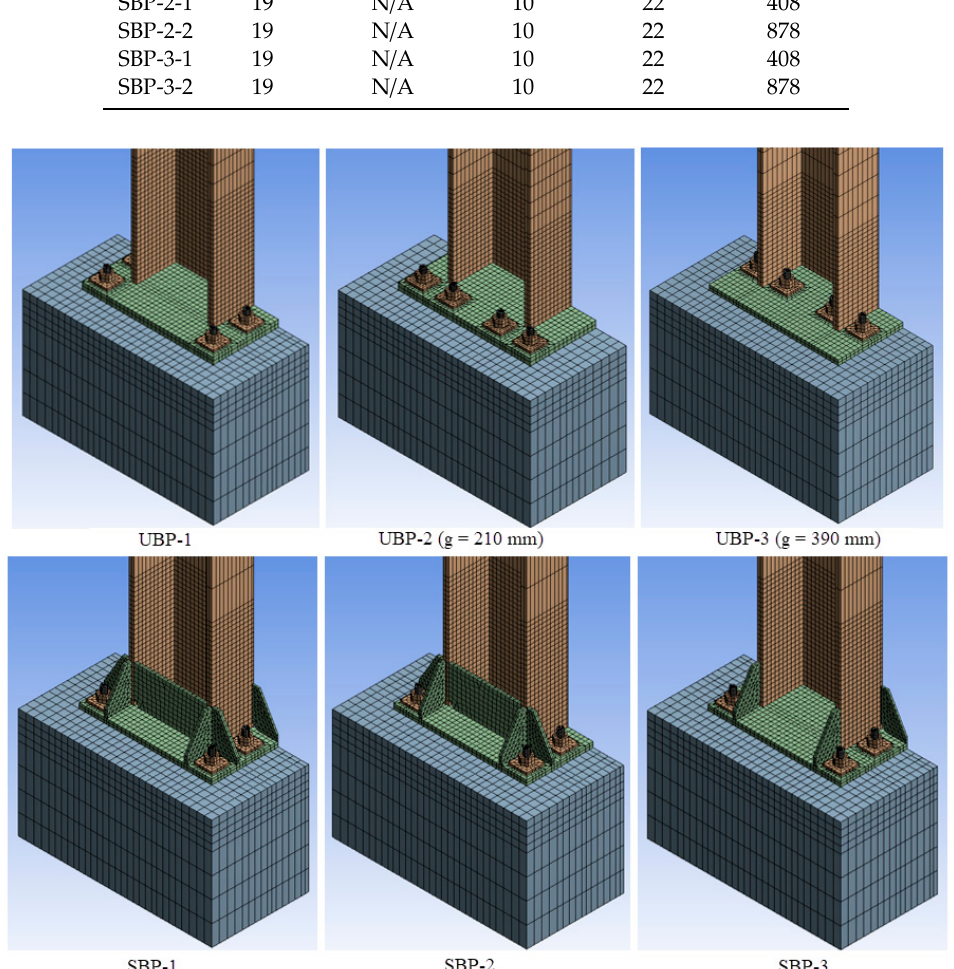
Figure 2. Finite element models for each specimen configuration.